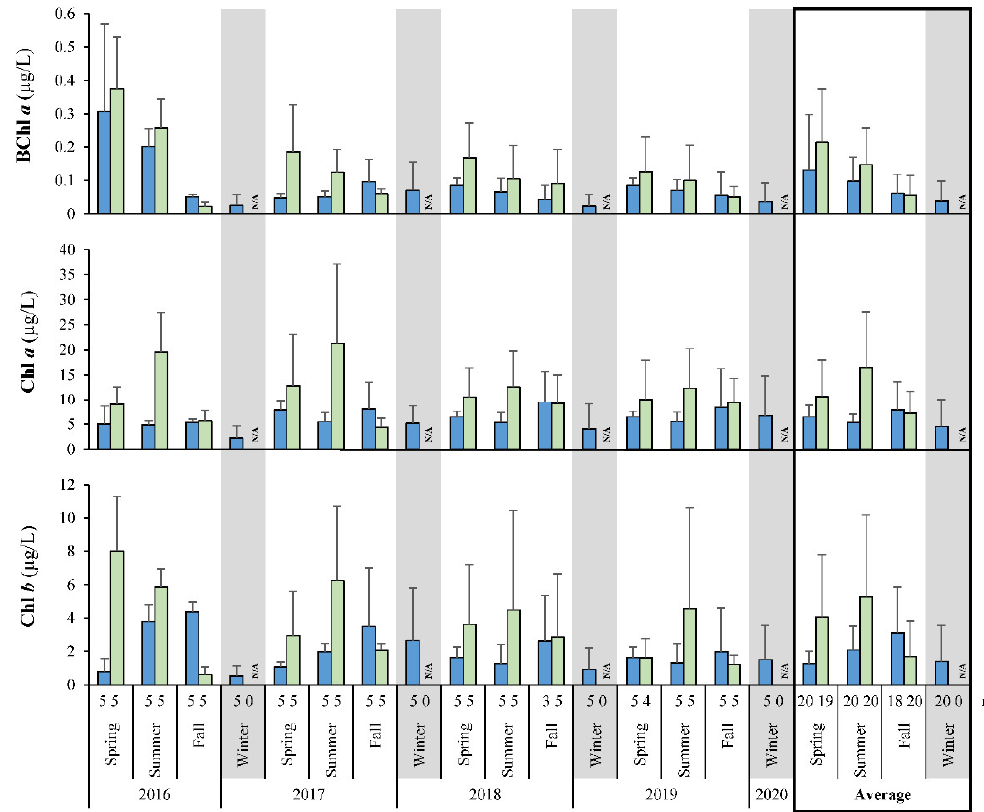
Figure A1. Photosynthesis primary pigment levels from each sampling location. Solvent extracts of collected biomass revealed BChl a , Chl a , and Chl b concentrations at limnetic (blue) or littoral (light green) zones. N/A, not analyzed; n, number of samples per season.